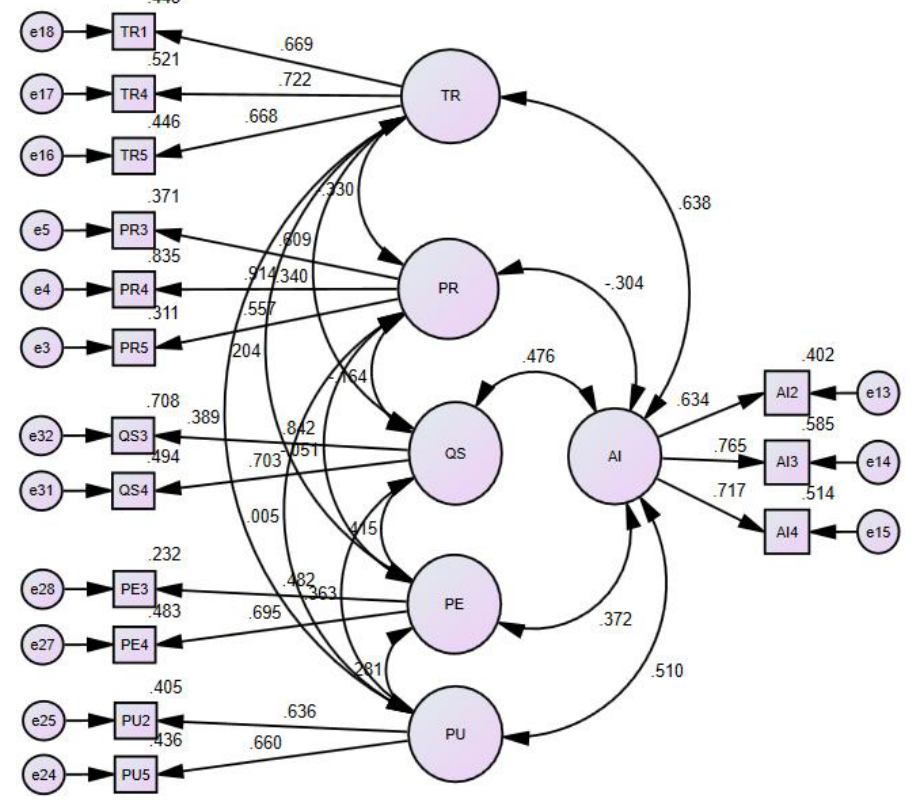
Fig. 3 The proposed model in CFA with standardised estimates